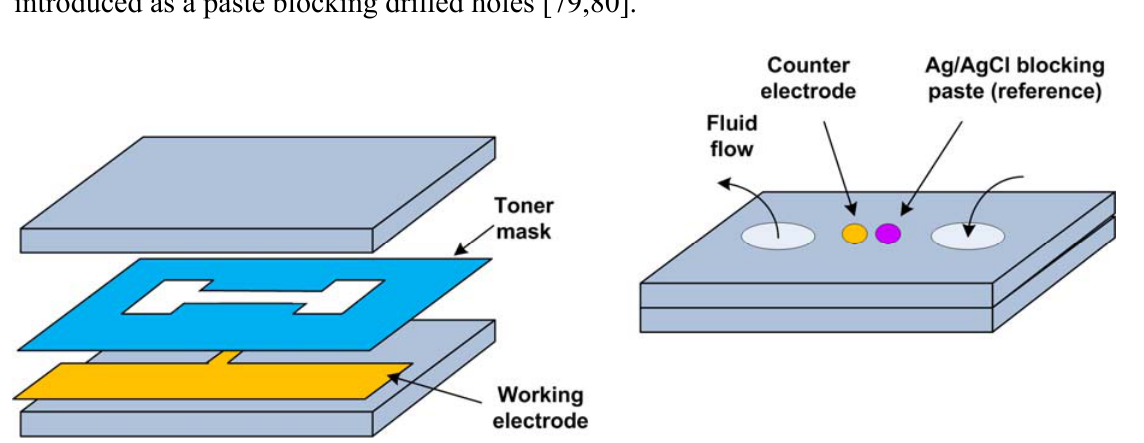
Figure 12. A microchannel made using toner mask, with the reference Ag/AgCl introduced as a paste blocking drilled holes